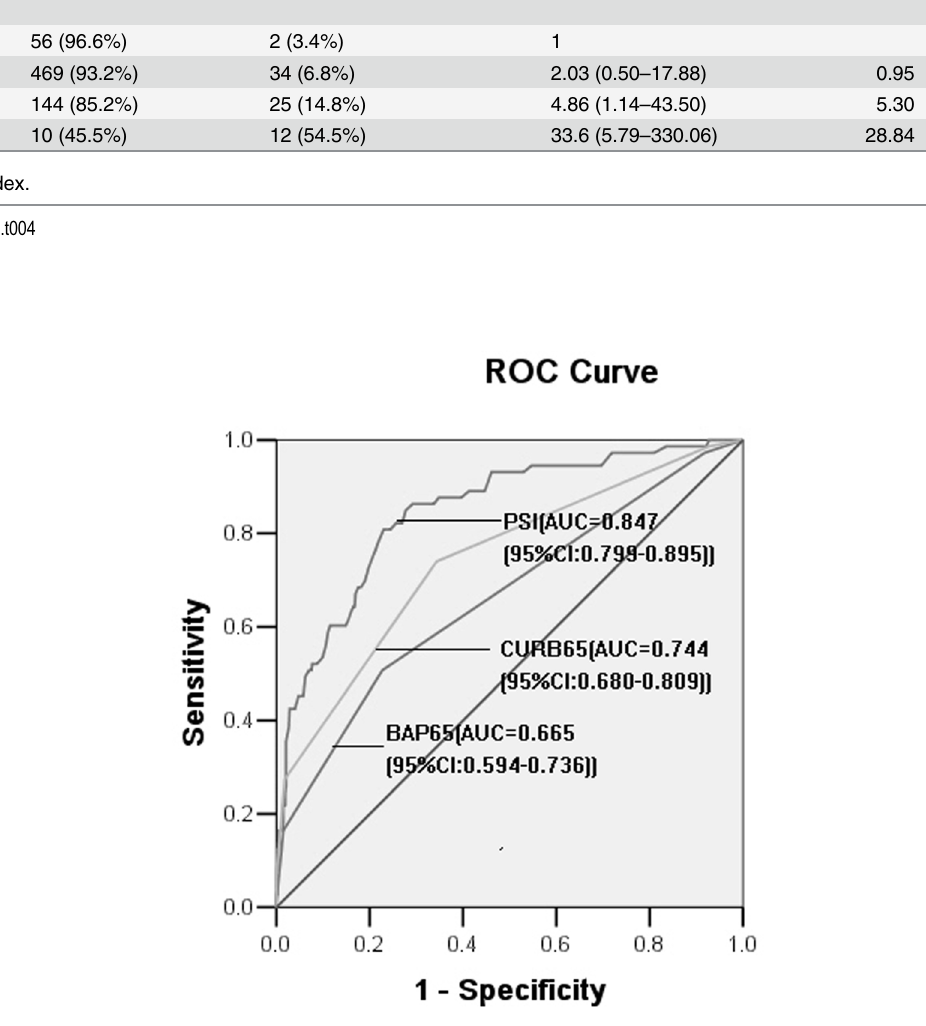
Fig 1. Receiver operating characteristic (ROC) curves for the PSI, CURB65 and BAP65 scores to predict in-hospital mortality in AECOPD patients. AUC: area under the ROC